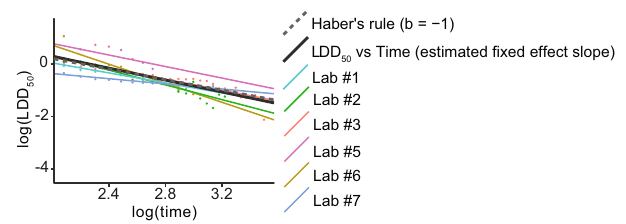
Fig. 4 Flupyradifurone (FPF) time-reinforced toxicity assessment. There is no evidence of time-reinforced toxicity of FPF in honey bees, as its toxicity (estimated global regression of the Lethal Daily Dose causing 50% mortality, LDD 50 ; black solid line) over time (days) was not signi fi cantly different from Haber ’ s rule (random slope mixed model; dashed grey line with a slope of − 1). We display separate regression lines, using different colours, for each laboratory. Further details are available in